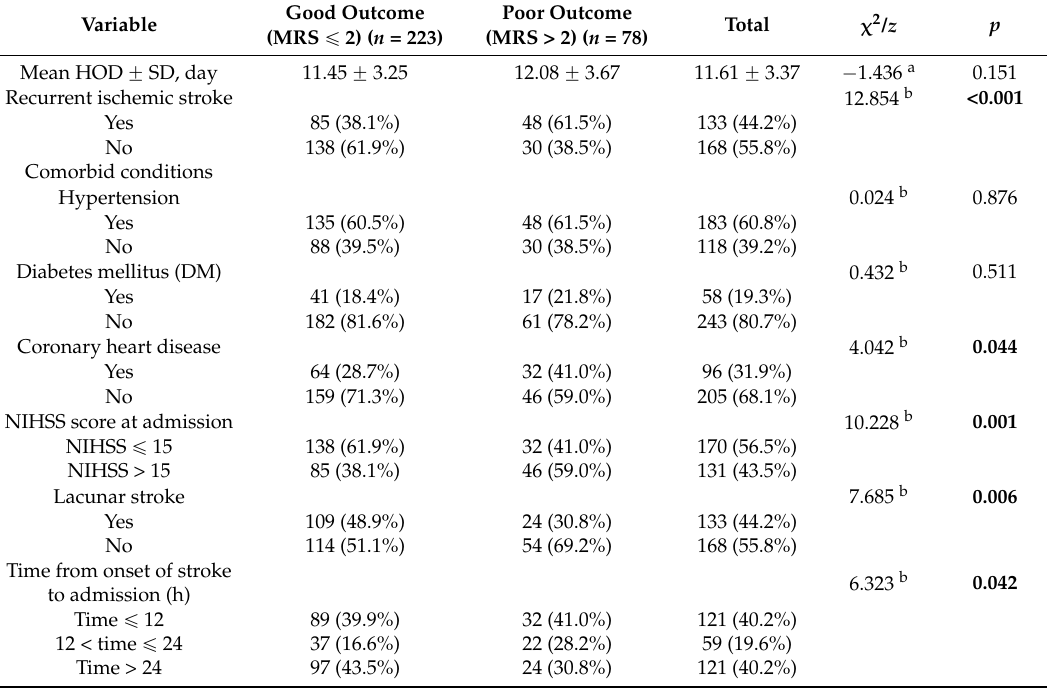
Table 2. Clinical factors related to outcome at discharge in acute ischemic stroke patients.